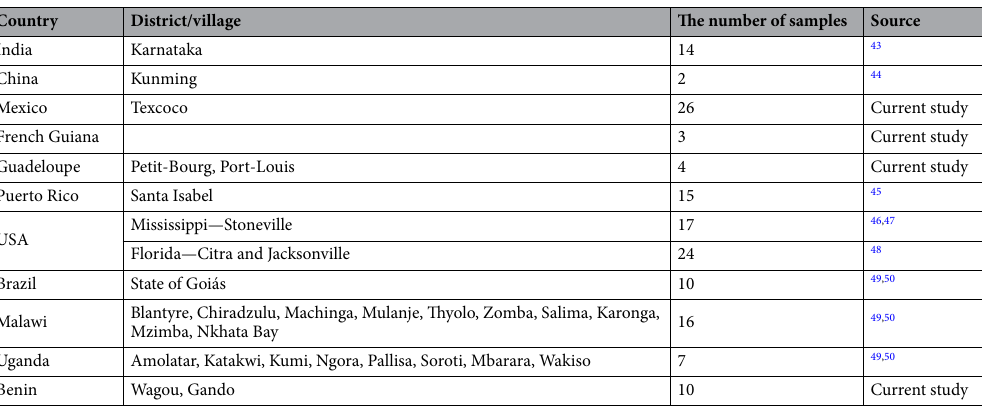
Table 1. Information of resequencing data used in the